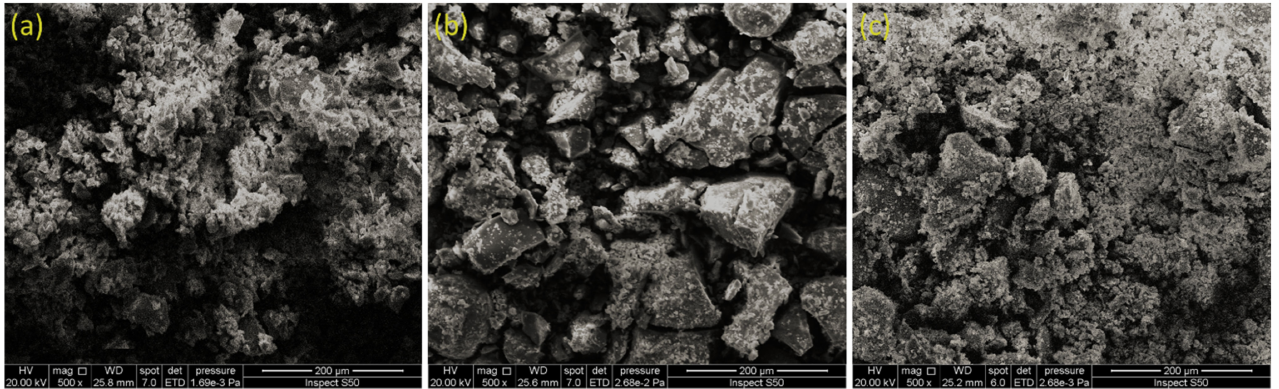
Figure 1. SEM images of ( a ) ibuprofen–Mn complex, ( b ) ibuprofen–Co complex, and ( c ) ibuprofen– Ni complex.